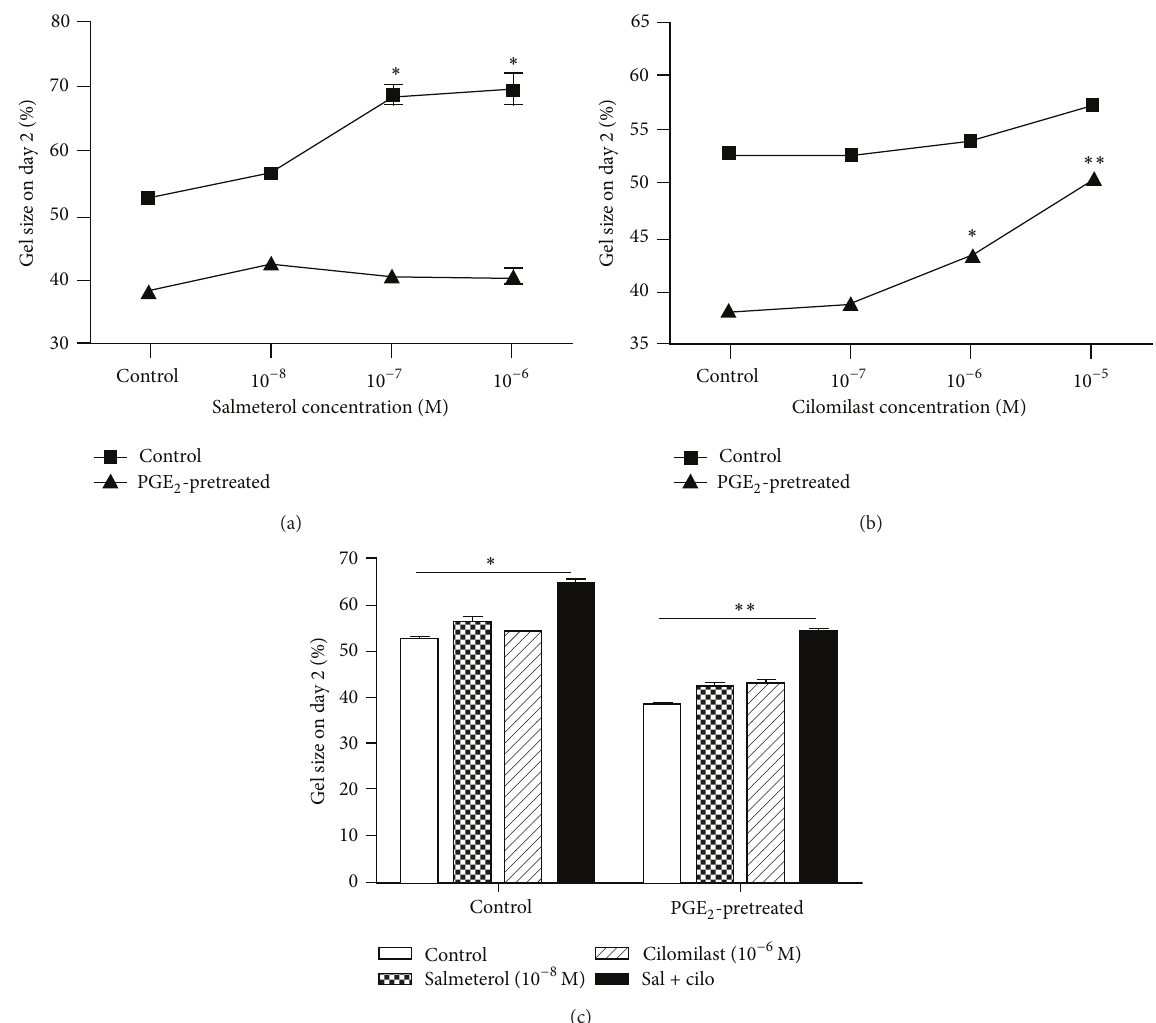
Figure 4: Exogenous PGE 2 pretreatment potentiates cilomilast but not salmeterol. Confluent HFL-1 cells were pretreated with SF-DMEM with or without 10 −9 M PGE 2 for 24hrs. The next day, cells were cast into collagen gels as described in Section 2. (a) PGE 2 pretreatment abolishedtheinhibitoryeffectofsalmeteroloncollagengelcontraction.(b)PGE 2 pretreatmentpotentiatedtheeffectofcilomilastininhibiting collagen gel contraction. (c) Effect of PGE 2 pretreatment on the synergistic effect of salmeterol and